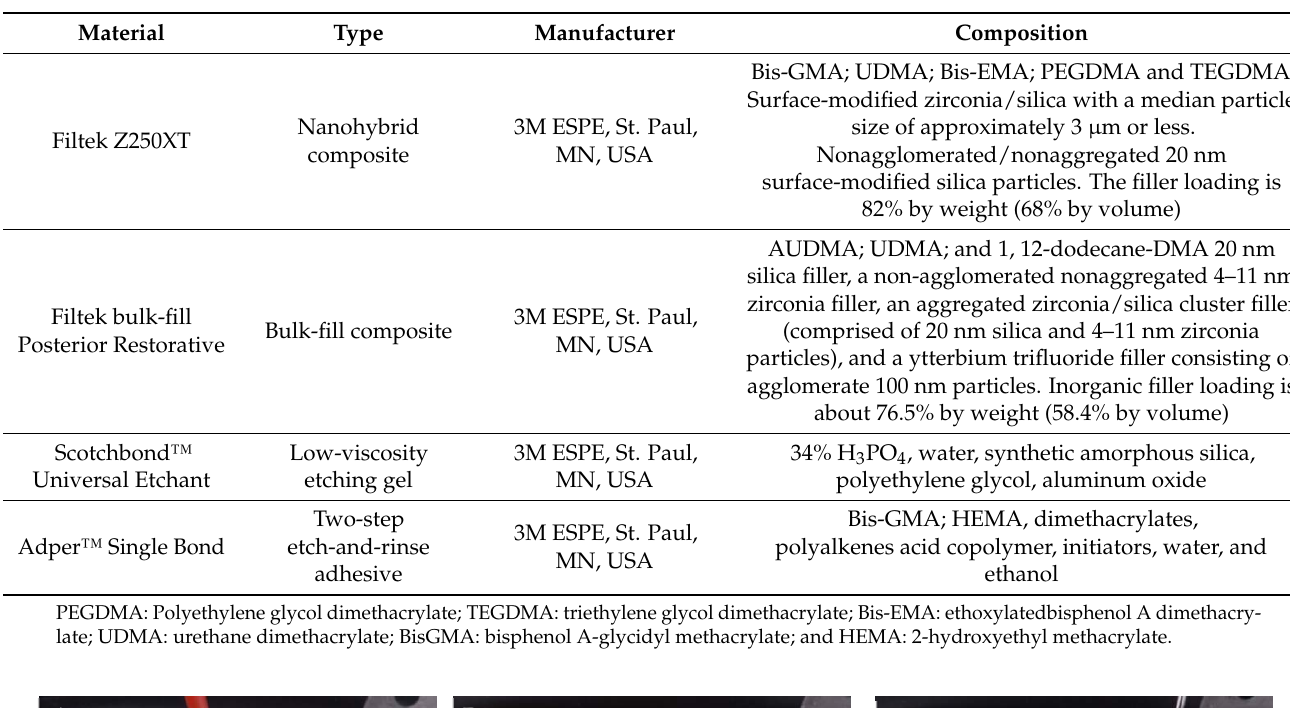
Table 1. Manufacturer and composition of the materials used for performing the restorations.